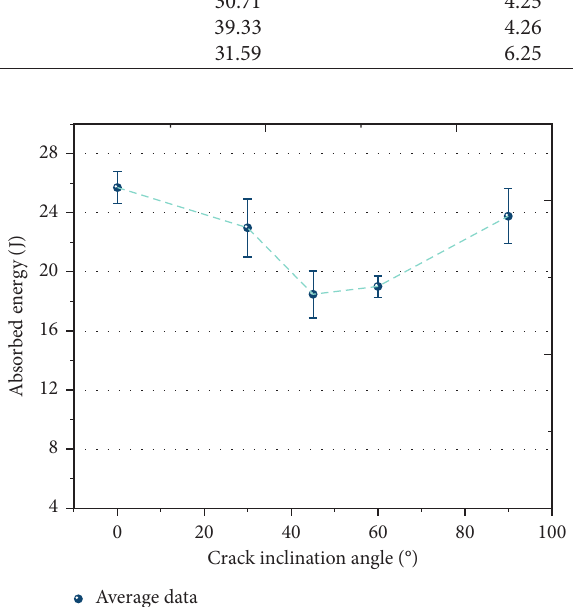
Figure 11: The relationship between the absorption energy E